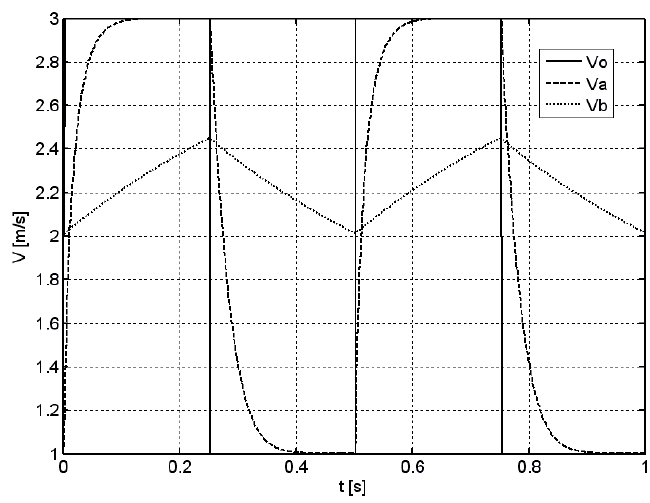
Figure 3. The time course of the response of vane anemometer with or without the optimization system to a rectangular excitation, v m = 2 m/s, k = 0.5, f = 2 Hz. Observed effects are similar to those obtained in the case of sinusoidal excitation.